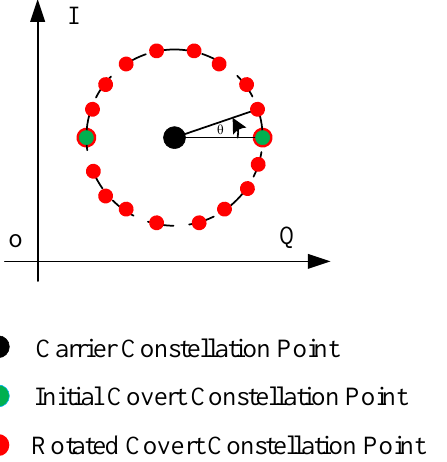
Figure 4. Rotation of polarized covert